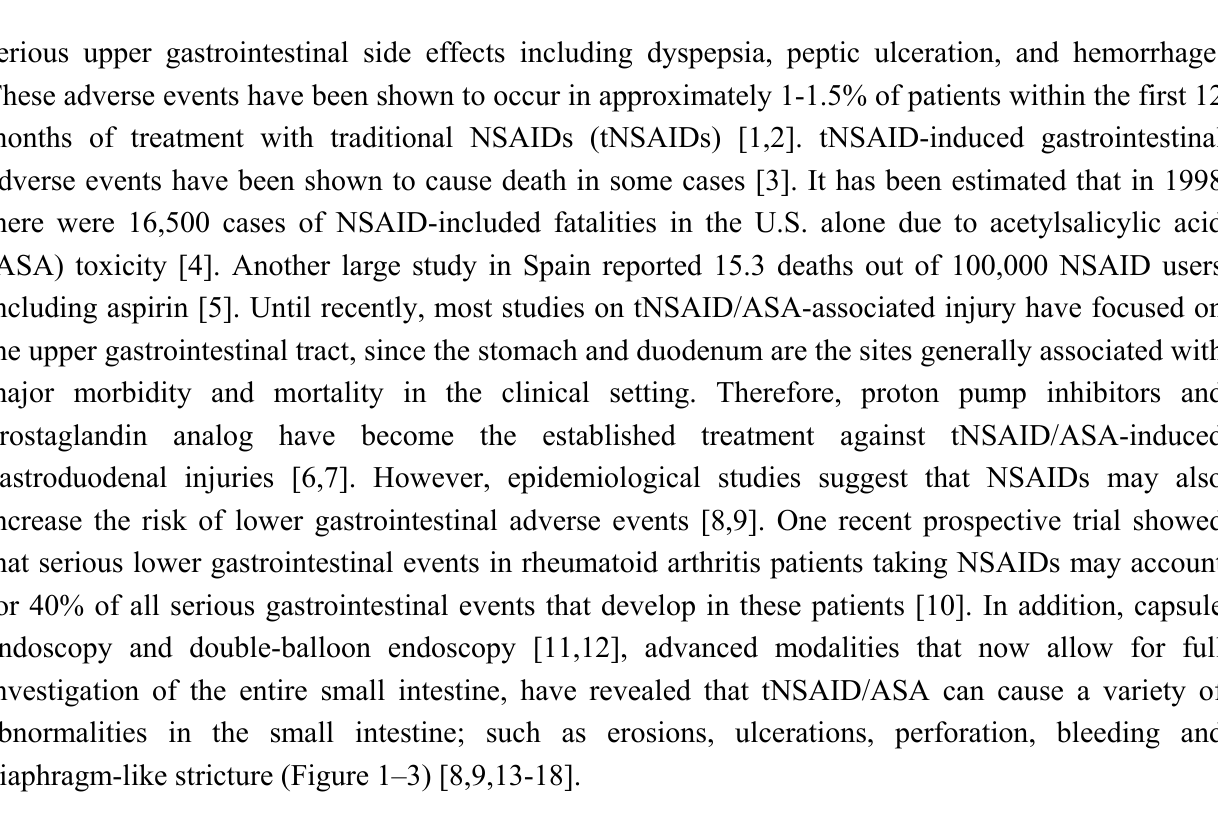
Figure 1. Traditional NSAIDs-induced small intestinal mucosal breaks